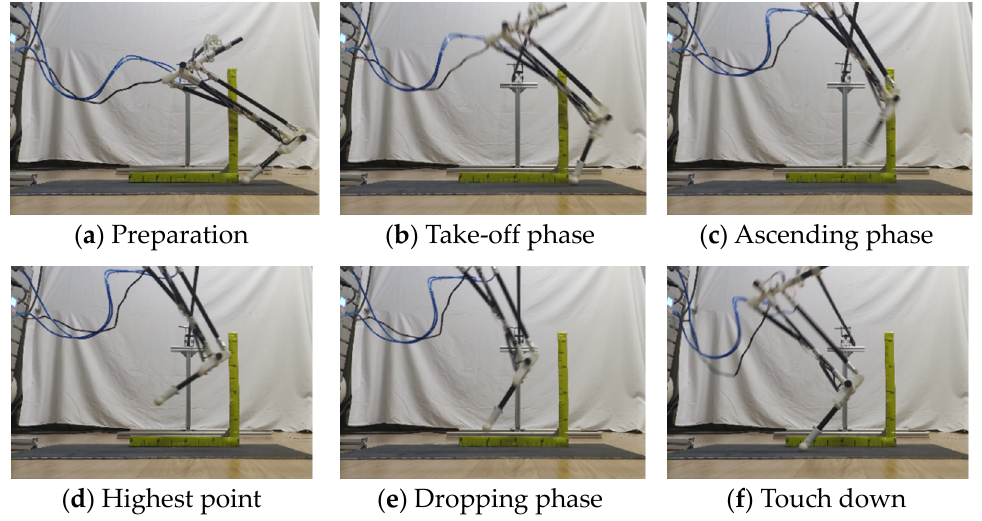
Figure 12. Bionic jumping leg